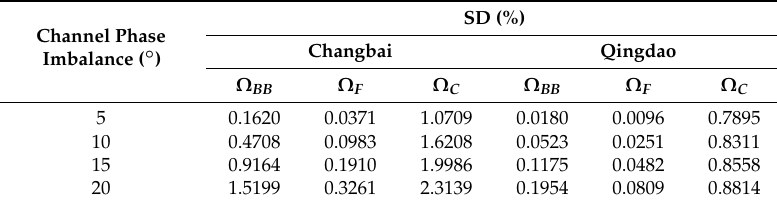
Table 6. SD ( σ SD ) under the condition of channel phase